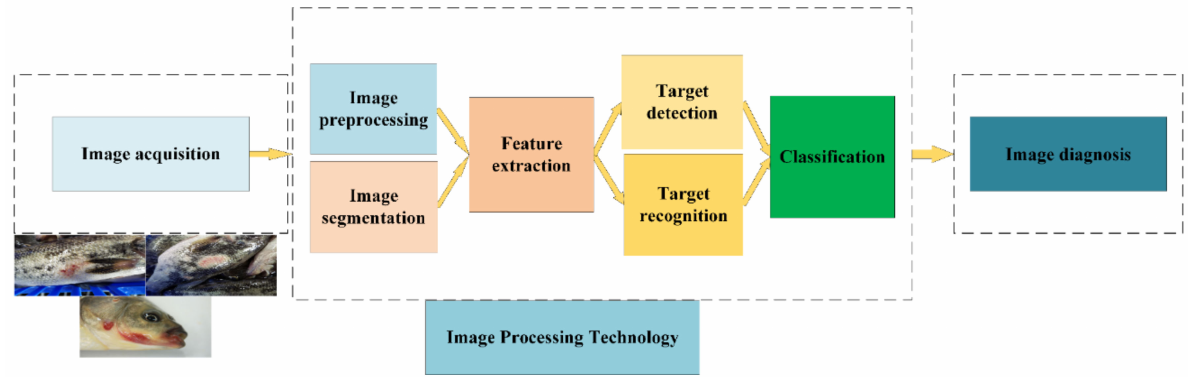
Figure 1. Illustration of the flow from acquisition of fish disease images through image-processing techniques to diagnosis.